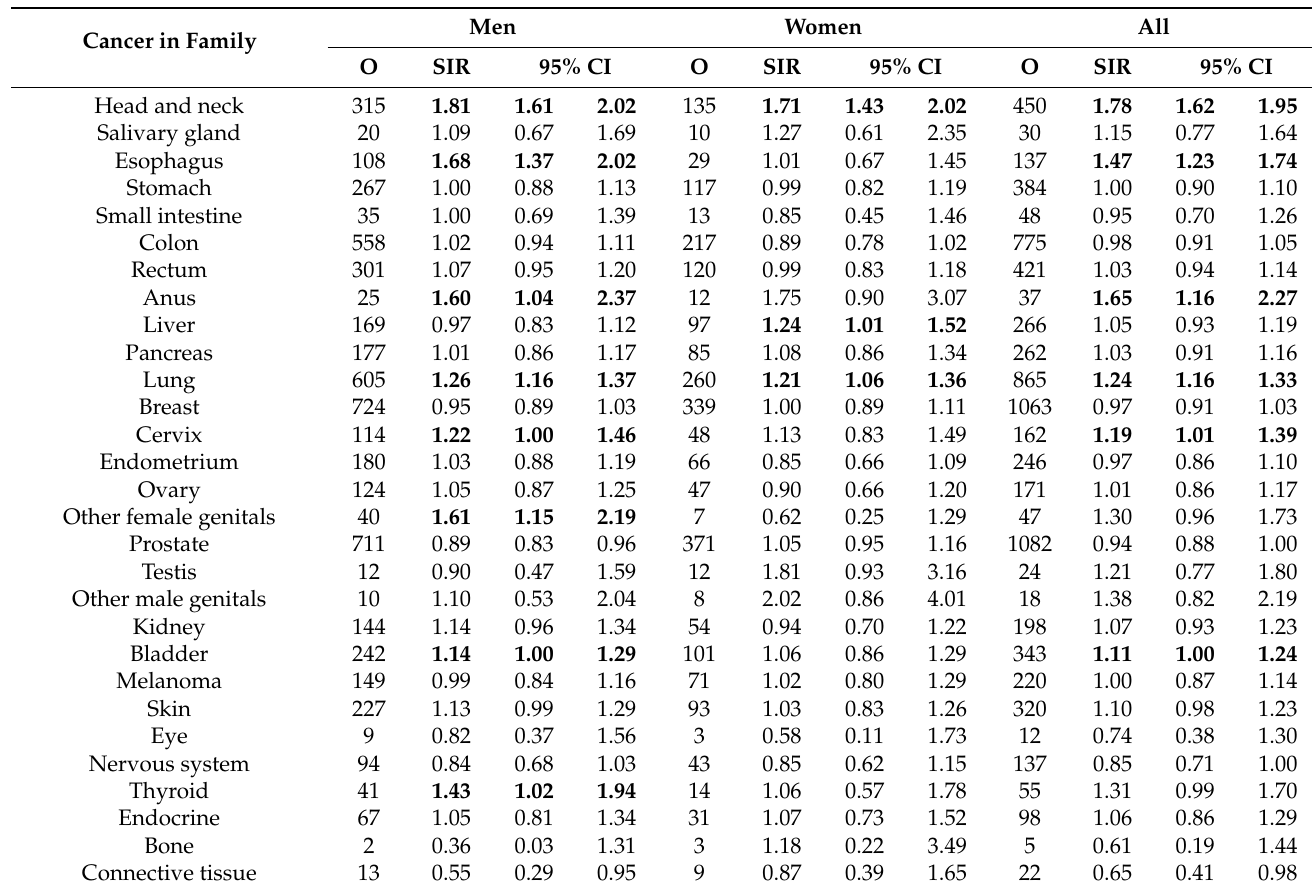
Table 2. Familial risk of head and neck cancers when family members were diagnosed with any cancer. Cancer in Family